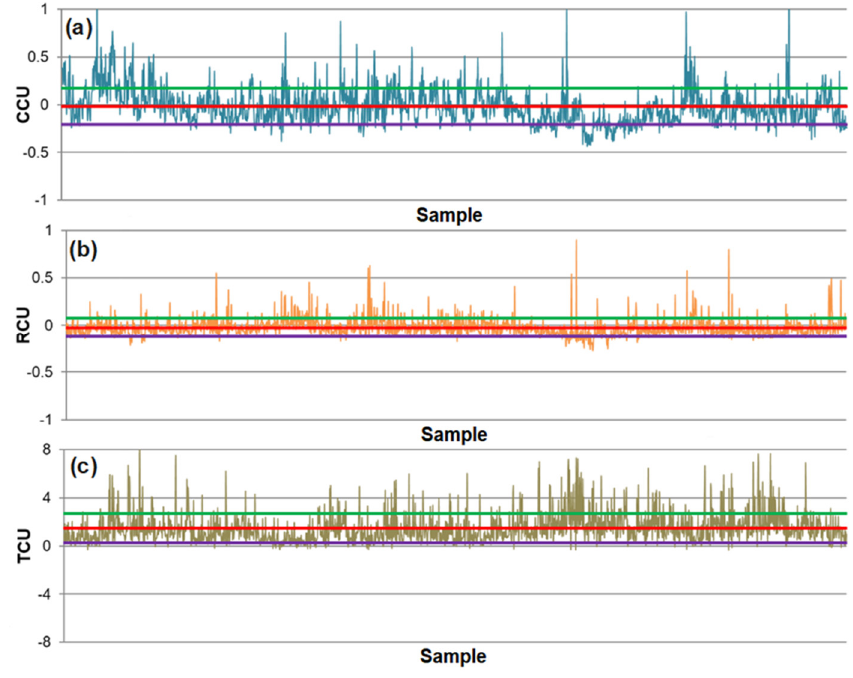
Figure 16. Relative prediction errors of technological indicators according to the PMM model: ( a ) CCU, ( b ) RCU and ( c ) TCU. The red line on the charts represents mean (μ r ), green line value μ r + 1 SDE r and violet line value μ r − 1 SDE r .